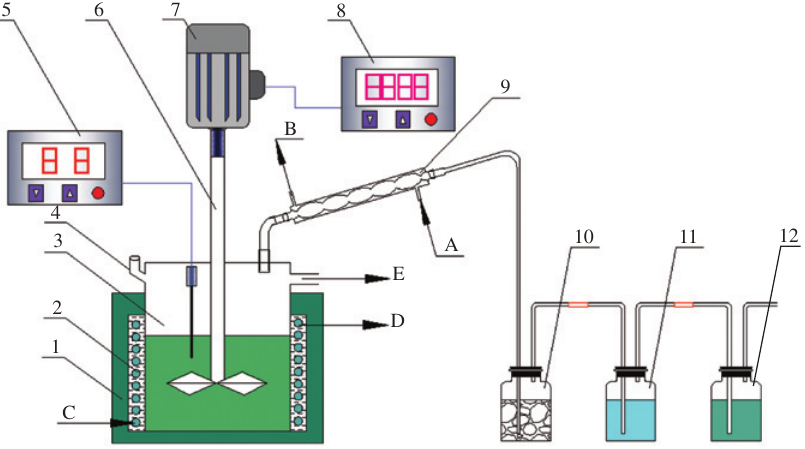
Figure 3: Schematic diagram of leaching system. 1 – Cell cavity, 2 – steam trace, 3 – reactor, 4 – feed inlet, 5 – digital display to control temperature measuring instrument, 6 – stirrer, 7 – electric mixer, 8 – digital display control instrument, 9 – condenser pipe, 10 – buffer bottle, 11 and12 – gas-washing bottle. (A) Condensation water inlet, (B) condensate outlet, (C) steam inlet, (D) steam outlet, (E) discharge port.